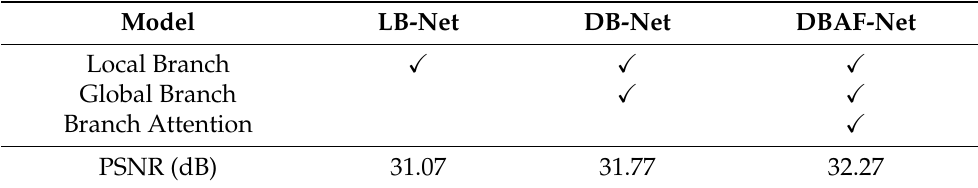
Table 1. Average Peak Signal to Noise Ratio (PSNR) Results of ablation experiments.